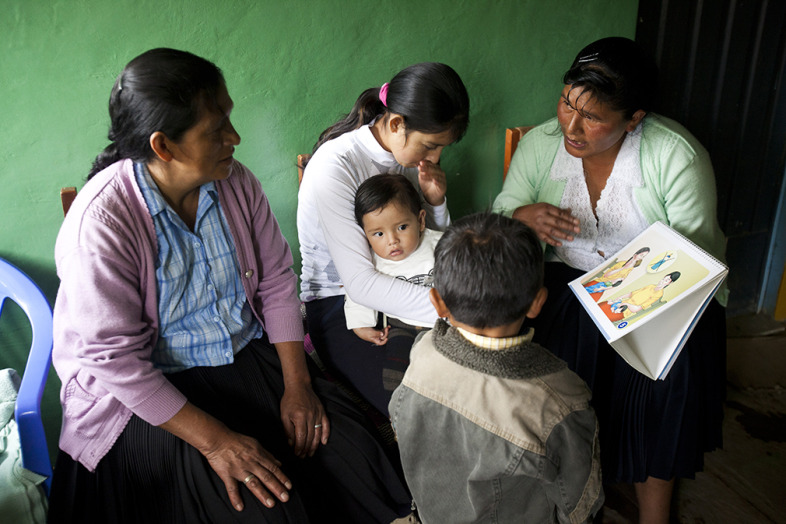
Community health worker asks a mother and grandmother what they see in the flip chart image. Credit: ©2013 Elie Gardner